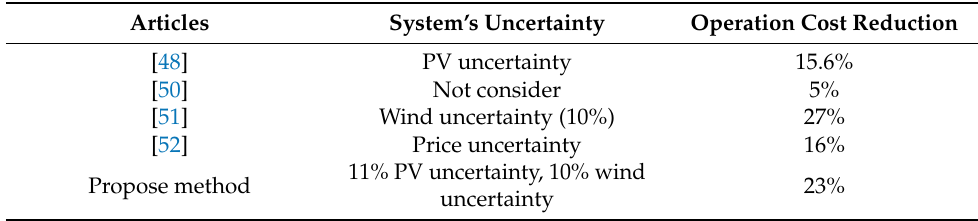
Table 4. Results comparison with existing